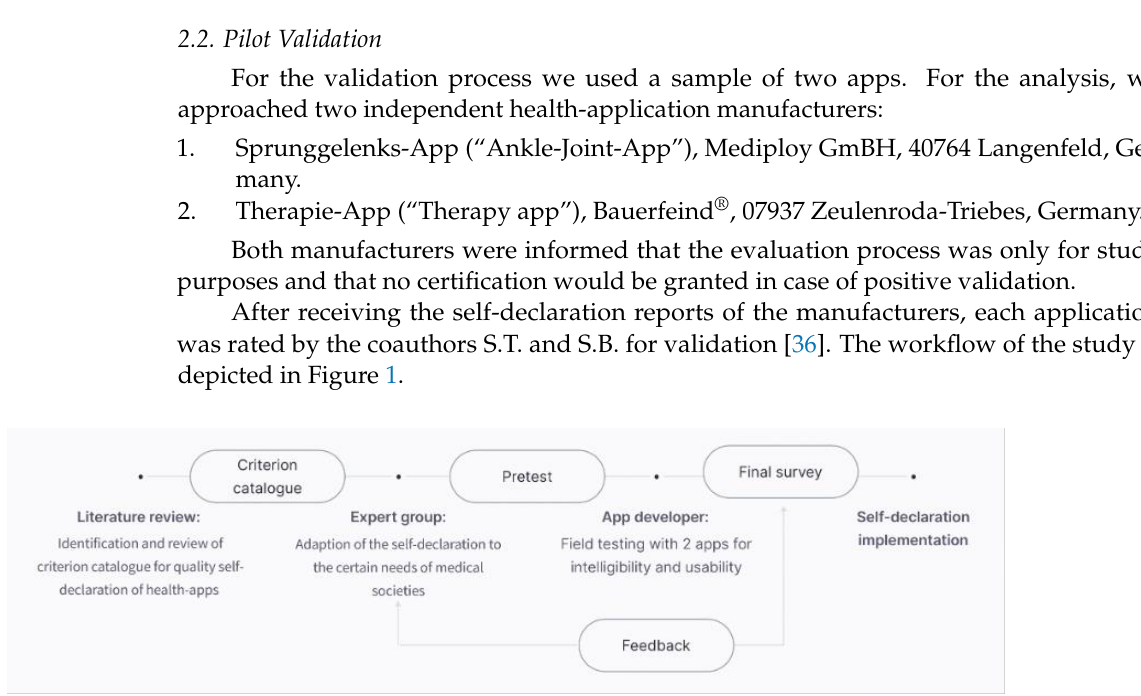
Figure 1. Workflow of the study.